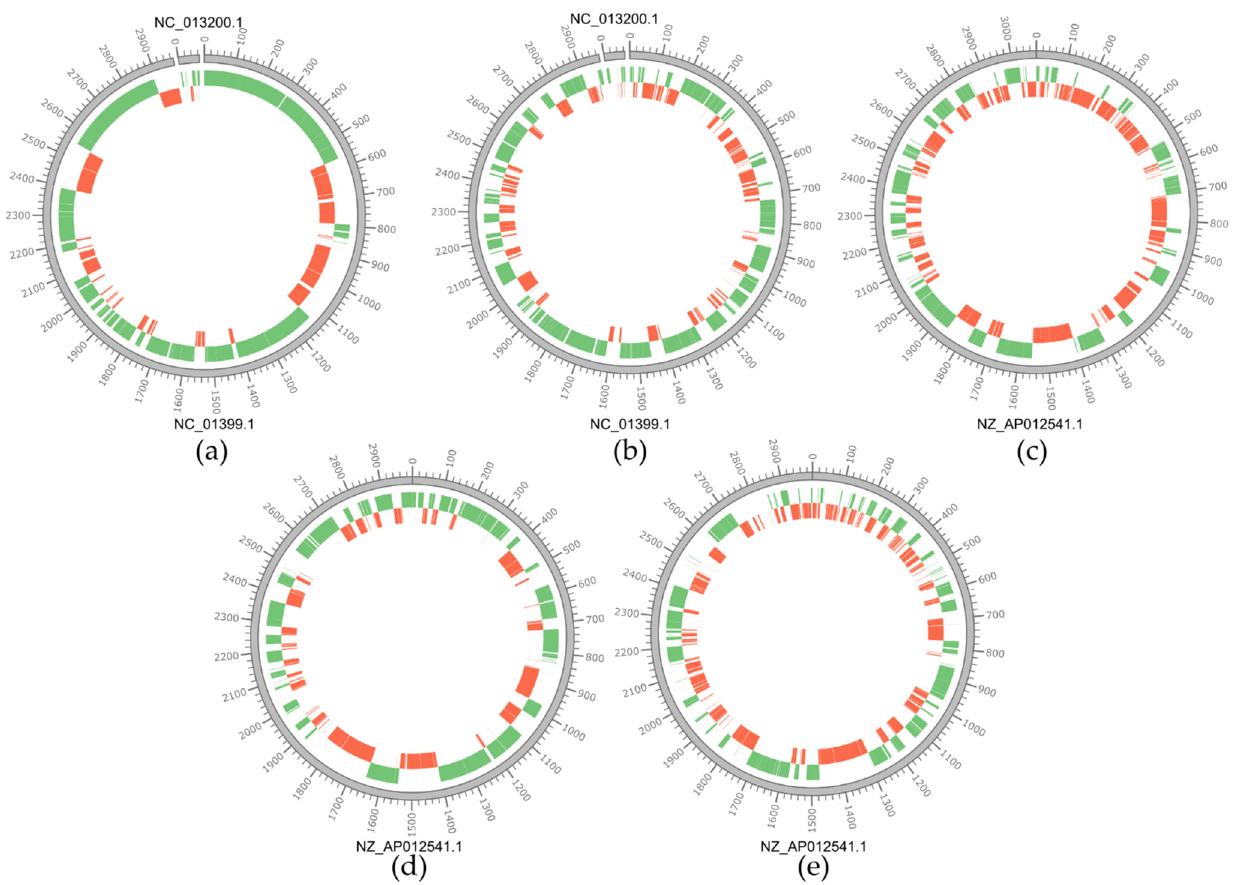
Figure 1. Circular representations of the chromosomes of Lacticaseibacillus isolates. The outer grey circle represents the genome of the reference strain used for the alignment, the green circle represents the contigs aligned with the reference sequence, the red circle represents structural contig rearrangements compared to the reference sequence. Genome scale is in Kbp. Below each circular representation the RefSeq accession number for each type strain is reported (see Table S1 for details). For strain L. rhamnosus Lc705 plasmid pLC1 was included in the comparison (RefSeq: NC_013200.1). ( a) L. rhamnosus 1019 vs. L. rhamnosus Lc705; ( b ) L. rhamnosus 1473 vs. L. rhamnosus Lc705; ( c ) L. paracasei 2306 vs. L. paracasei JCM8130; ( d ) L. paracasei 2333 vs. L. paracasei JCM8130; ( e) L. paracasei 4186 vs. L. paracasei JCM8130.